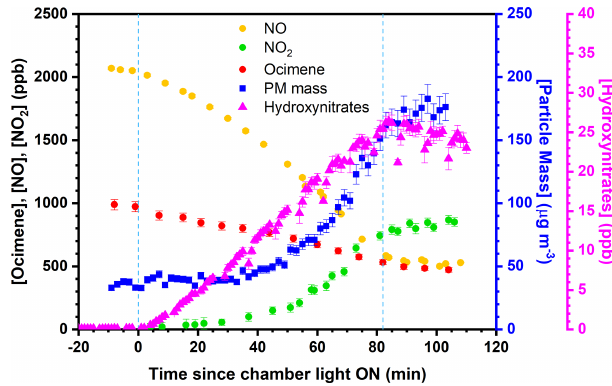
Figure 1. Time series of β -ocimene oxidation and particle forma- tion for experiment no. 6. Measurements presented are represen- tative of all online measurements obtained during chamber exper- iments. The error bars represent the propagated analytical uncer- tainty and blue dashed lines represent the time of UV light irradia- tion. (PM = particulate